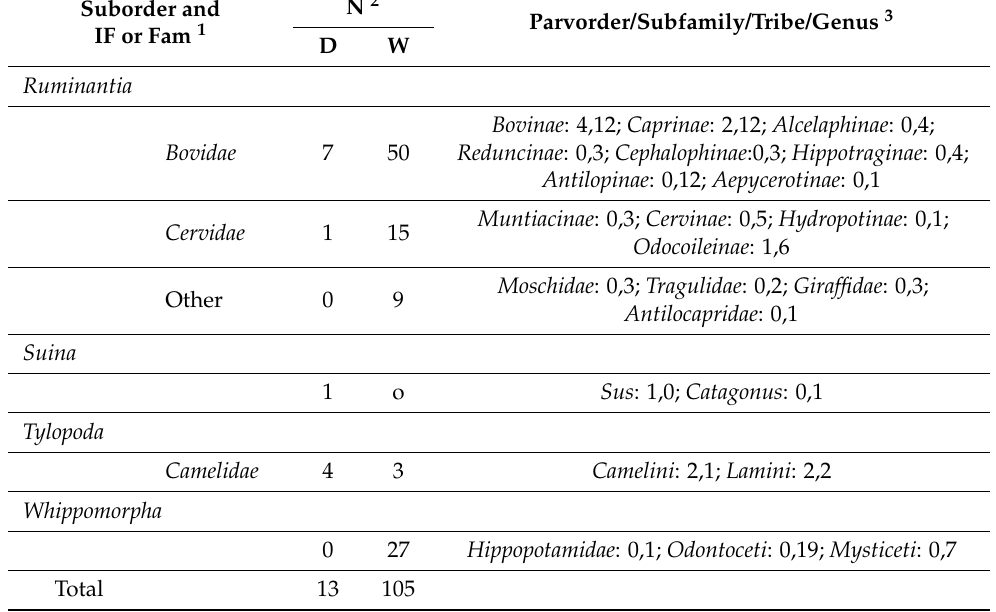
Table 1. Summary of domestic and wild Cetartiodactyla species used by taxonomic